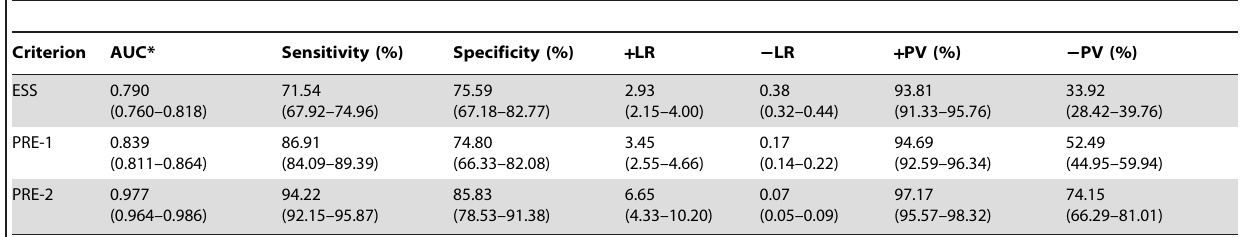
Table 4. The efficiency for detecting OSA with ESS, PRE-1 and PRE-2 versus PSG in the validation cohort (n=784).